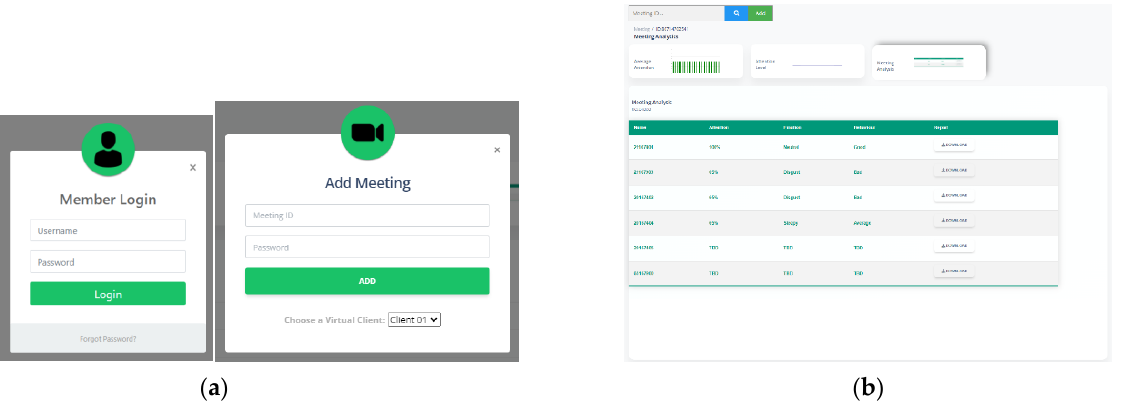
Figure 6. Dashboard views: ( a ) login and add meeting windows; ( b ) meeting analysis table view.